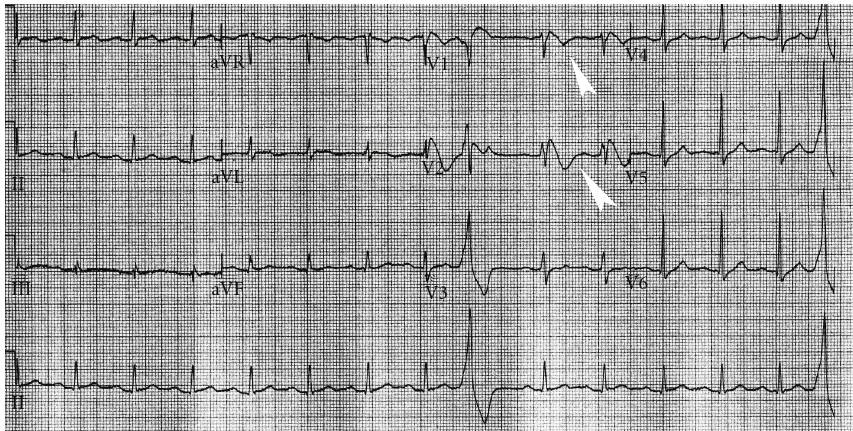
Figure 1: Electrocardiogram showing descendent ST-segment elevation with negative T waves (white arrow heads) in the right precordial leads V1 and